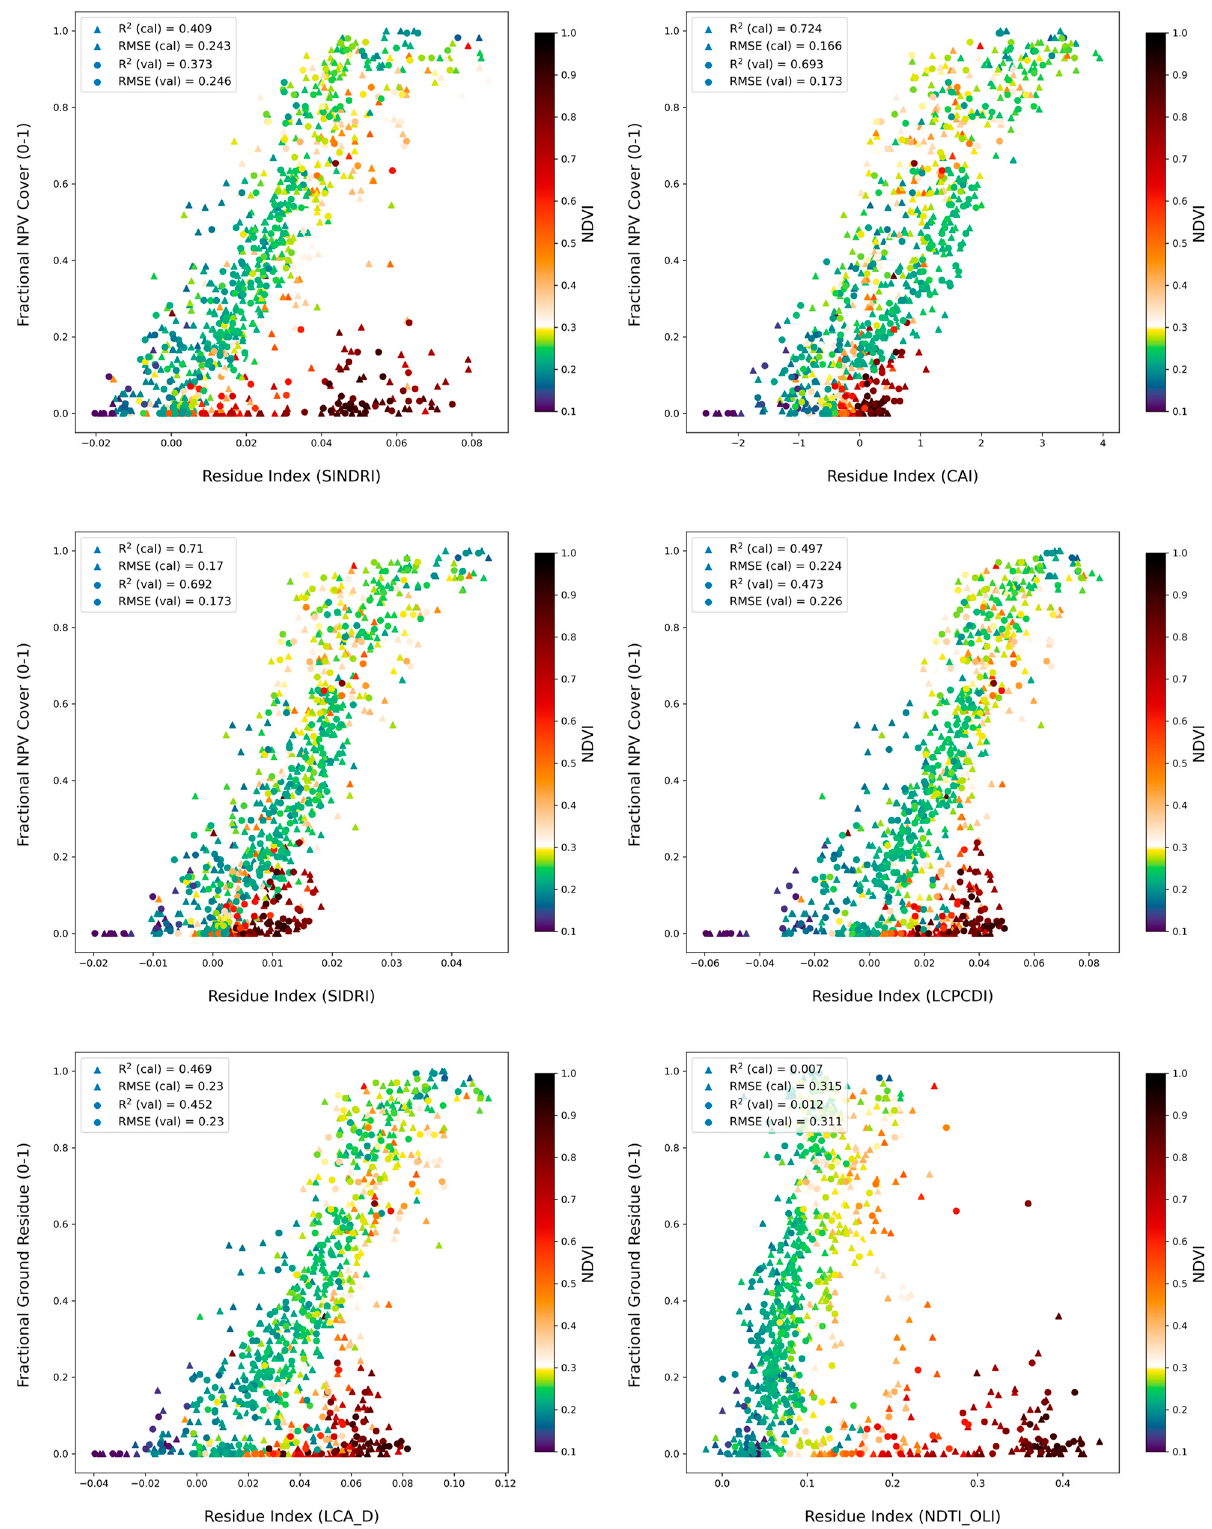
Figure 9. Scatterplots of selected shortwave infrared (SWIR) indices and fraction non-photosynthetic vegetation (NPV) cover, relative to amount of vegetation (NDVI), using 916 spectra with NDVI < 1.0 (650 spectra with NDVI < 0.3)). See Table 1 for index definitions. Indices were calculated using boxcar spectra at 20, 20, 40, 40, 50 nm bandwidth for the 2040, 2100, 2210, 2260, and 2330 nm bands, respectively.